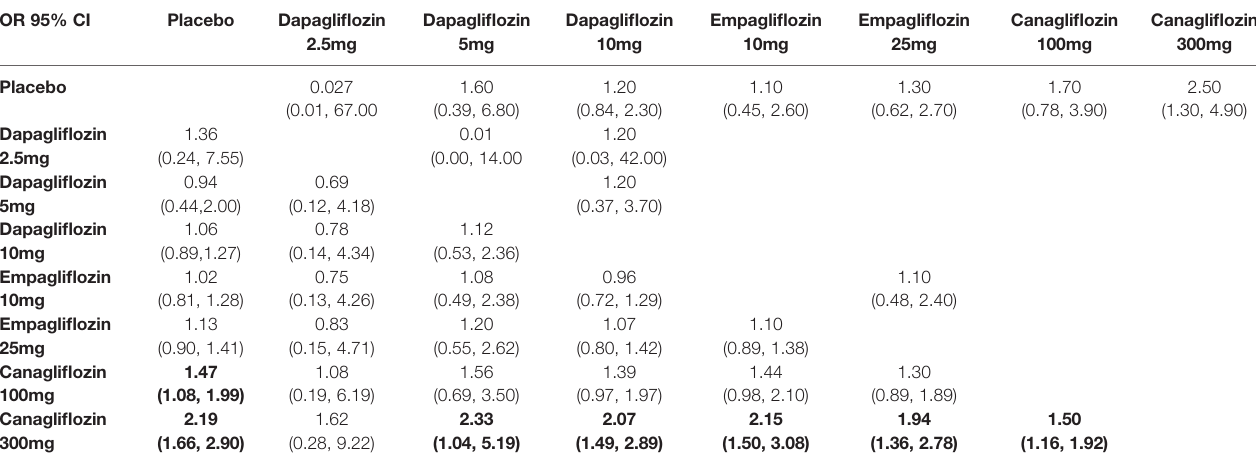
TABLE 3C | Summary of results from network meta-analysis and traditional pairwise meta-analysis on volume depletion. OR 95% CI